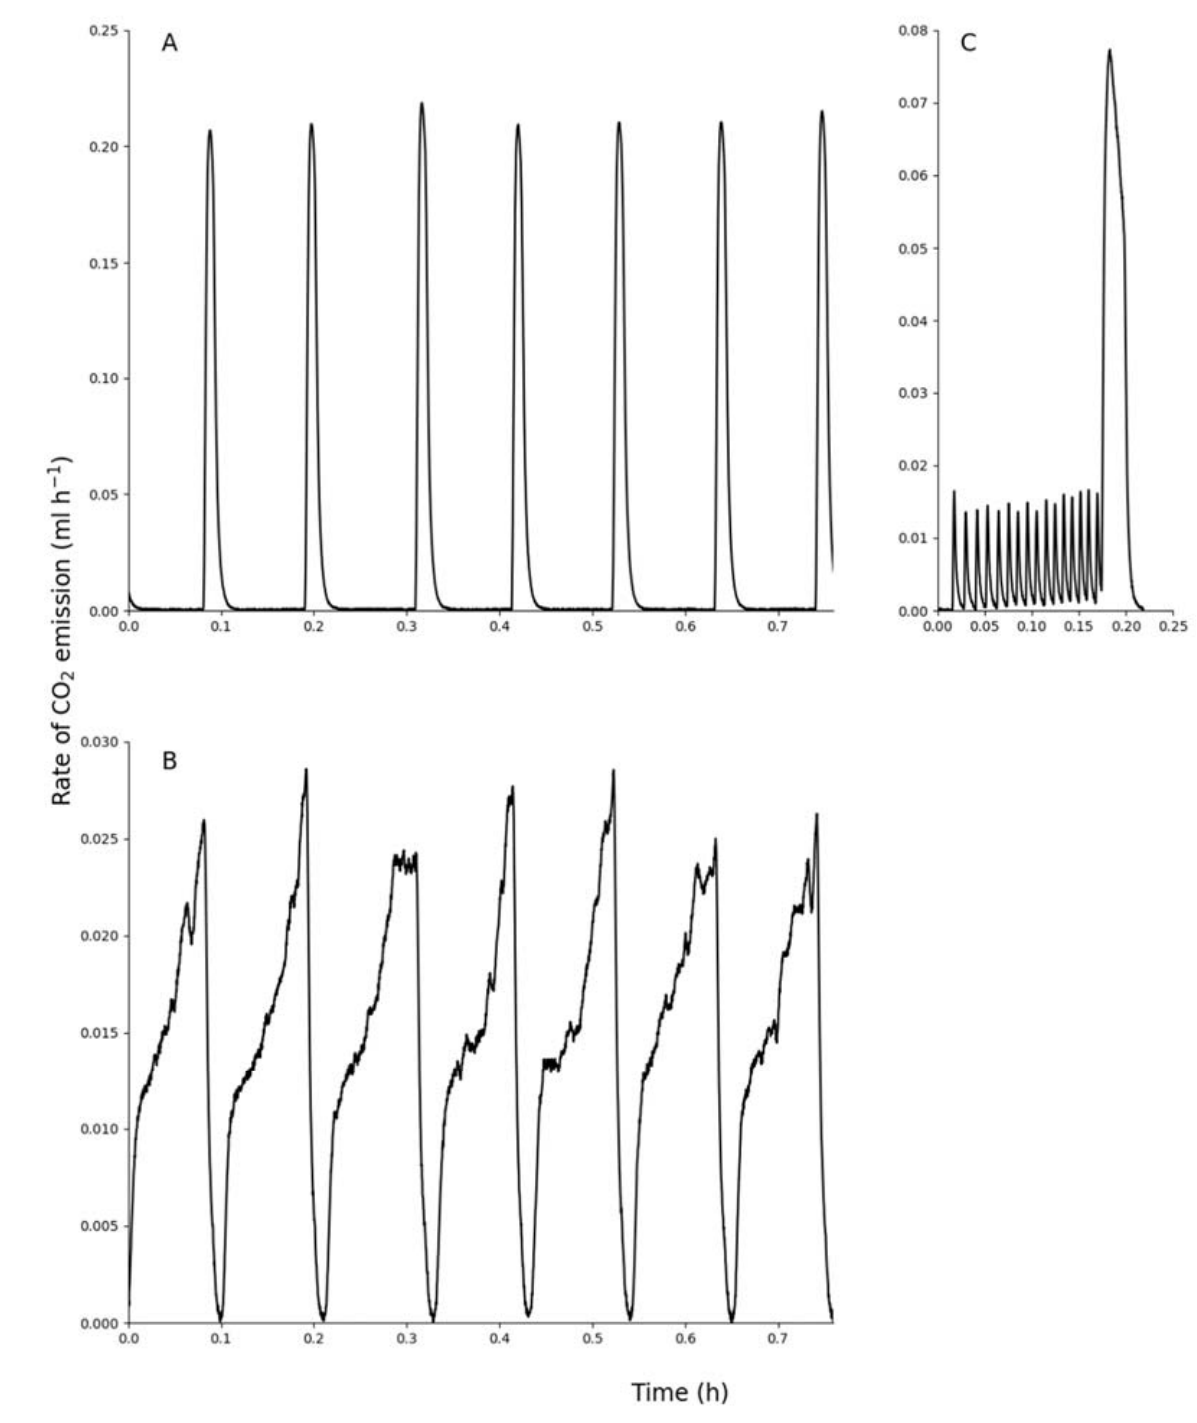
Figure 3. Recording of CO 2 emission from the mesothoracic spiracles ( A ) and elytral case ( B ) simultaneously in M . depressus (mass = 0.21 g). For comparison, ( C ) shows one discontinuous gas exchange cycle from the mesothoracic spiracles of a beetle exhibiting the flutter period (mass = 0.18 g).